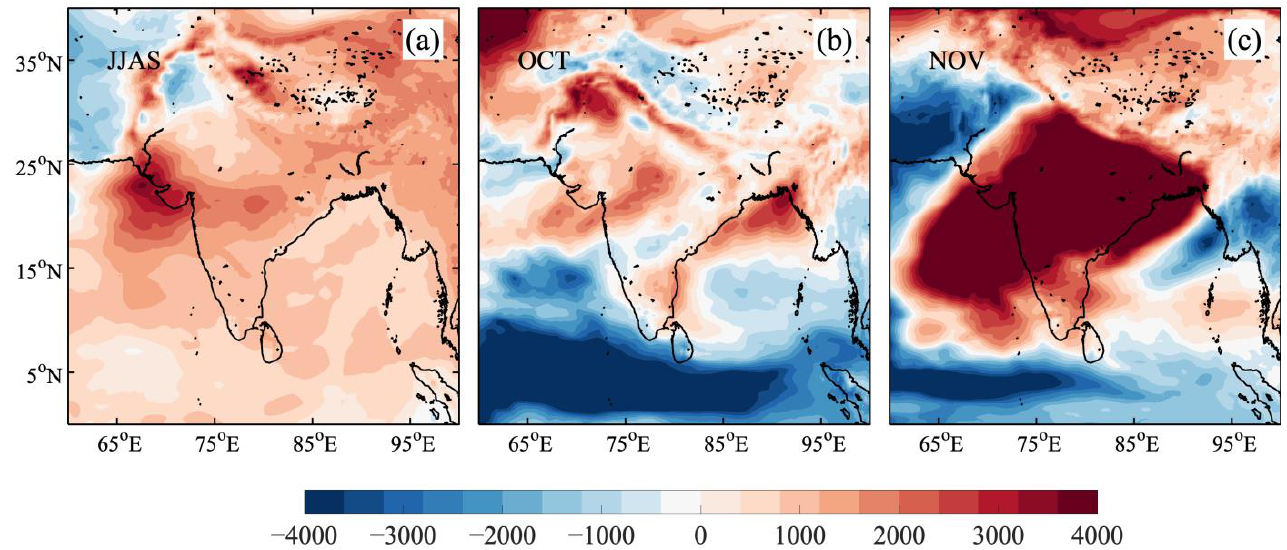
Figure 12. Moist static energy anomalies at 850 hPa (shaded; J/kg) ( a ) from June to September, ( b ) in October, ( c ) in November in 2010 based on ERA5 data.